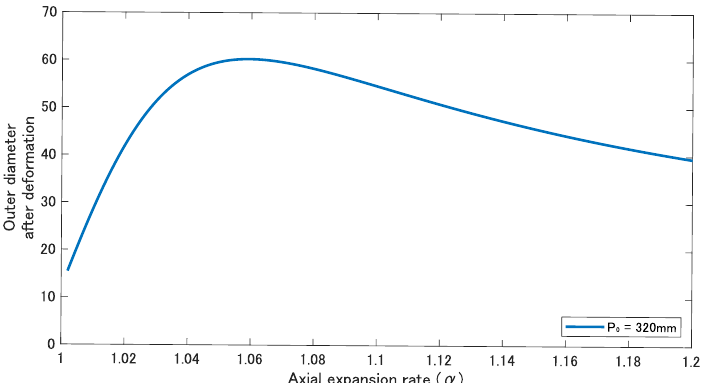
Figure 8. Relationship between the axial expansion rate and the outer diameter after